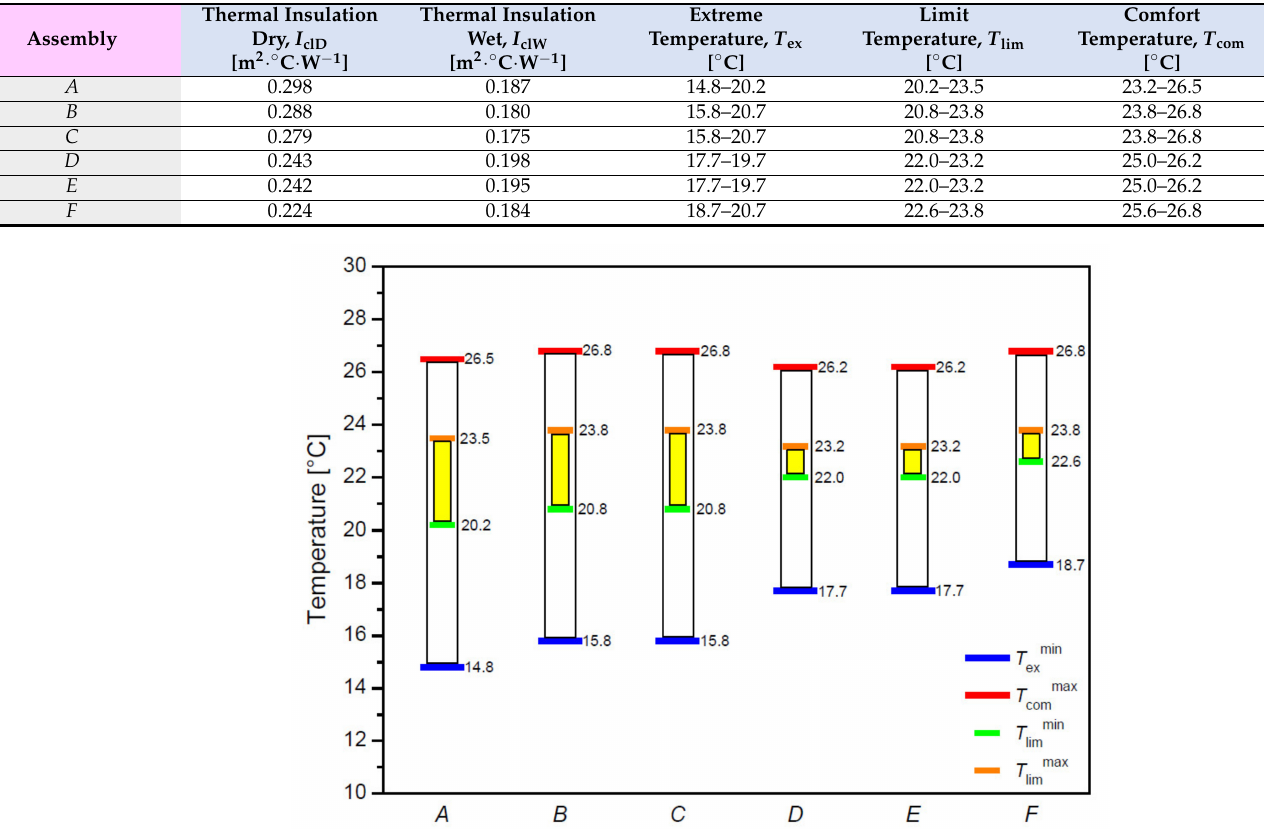
Table 5. The sleeping bag’s comfort, limit, and extreme temperatures ( T com , T lim , T ex ) were determined on the basis of the thermal resistance mean posture, according to the physiological model described in PN-EN ISO 23537-1:2017-02/A1:2018- 05 [42].